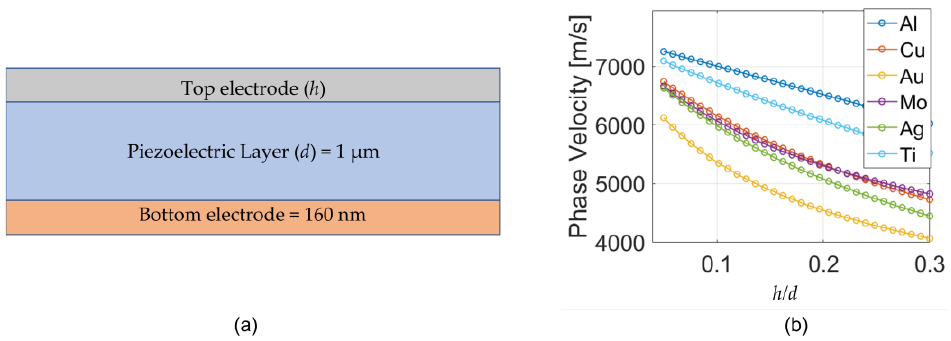
Figure 1. Material library of the design algorithm. ( a ) Cross-section of the model used for the systematic studies. ( b ) Obtained calibration curves.